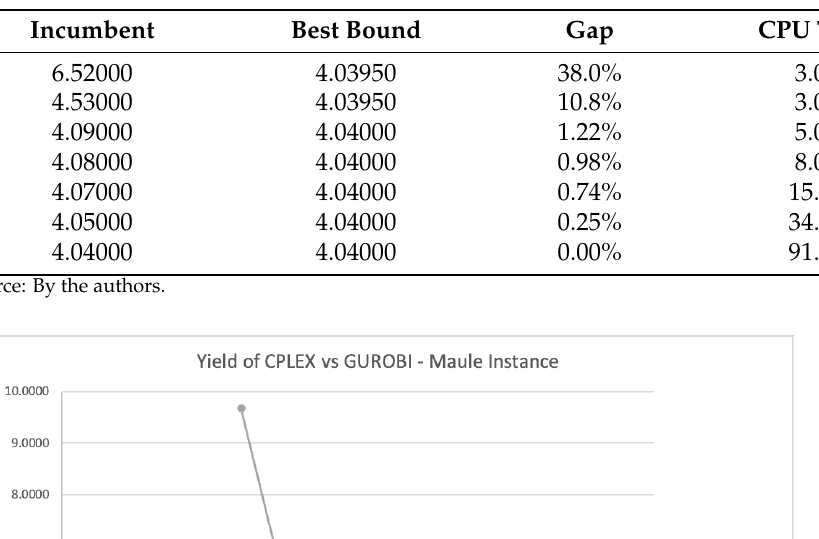
Table 3. Performance GUROBI solver—Maule Instance.